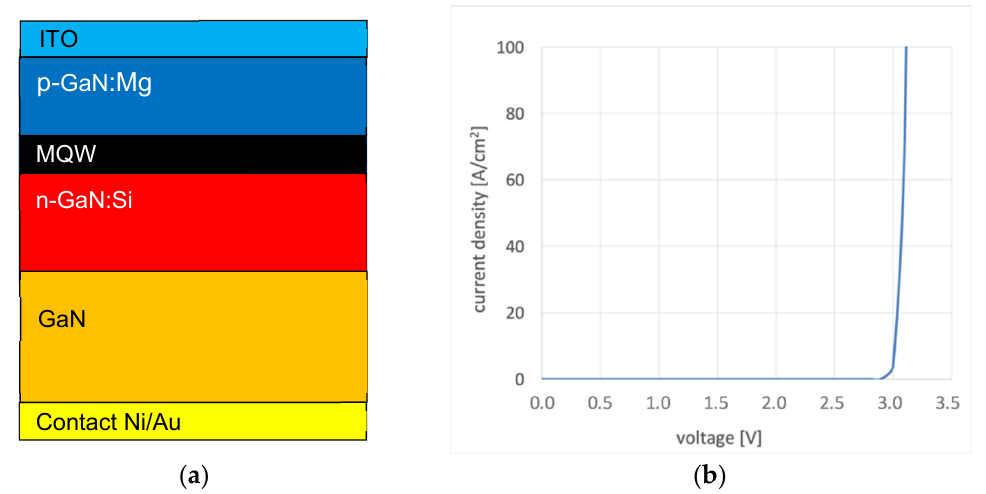
Figure 3. Simple vertical structure ( a ) and its I–V characteristic ( b ).